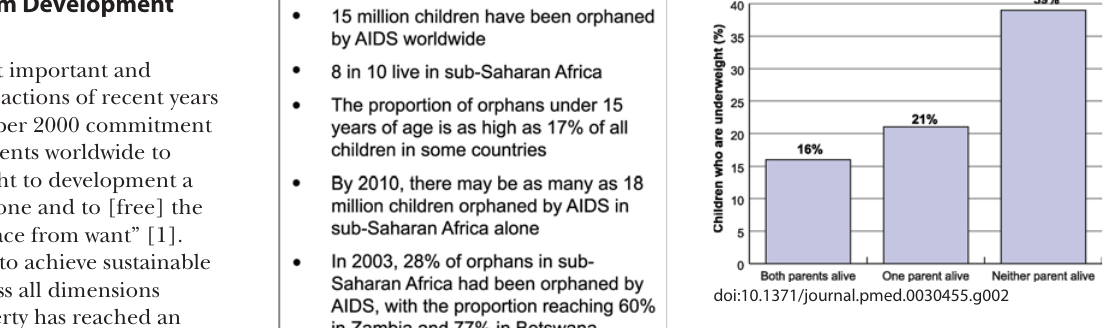
Figure 2. Underweight Prevalence among Children Under Four, Lesotho Figure derived from